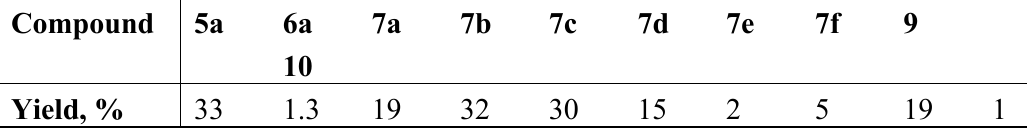
Table 1. Representative yields for products of incorporation of